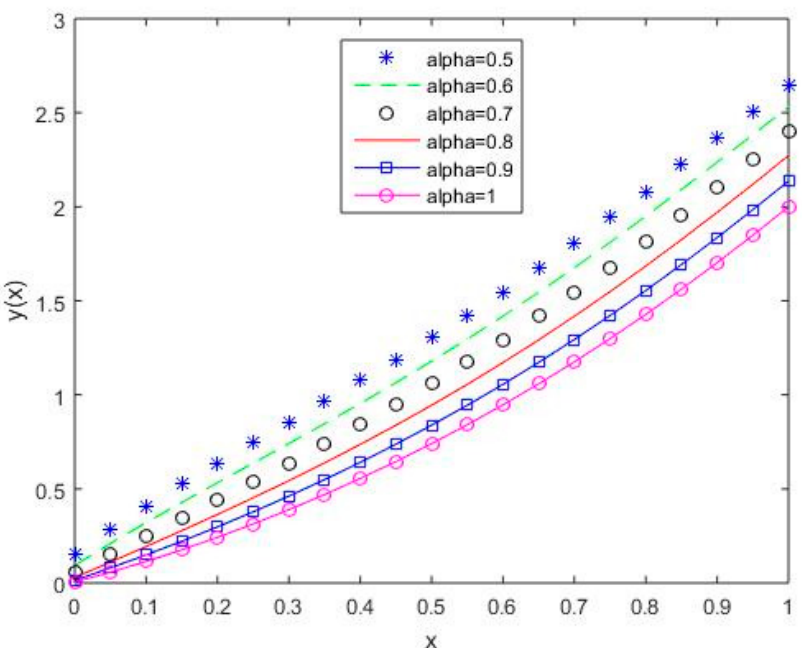
Figure 17. The behavior of solutions using S2 for α values of 0.5, 0.6, 0.7, 0.8, 0.9, and 1, Example 2.